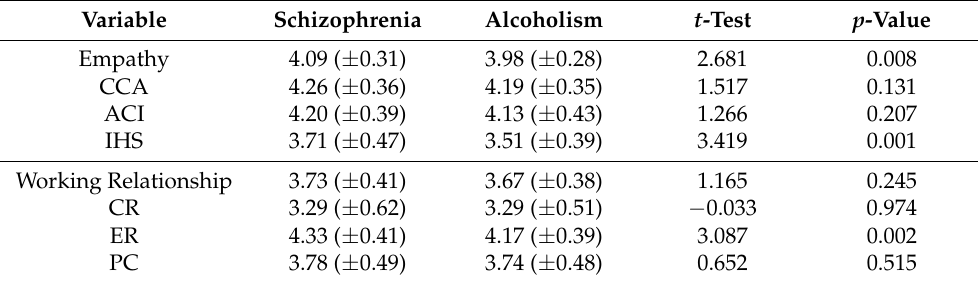
Table 2. Comparison of mean scores of empathy and WR between vignettes. Variable